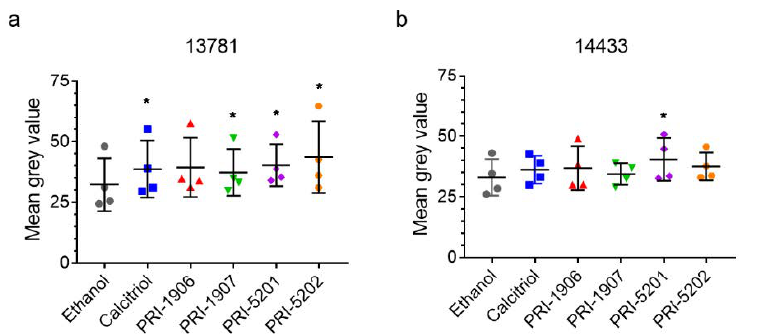
Figure 6. Nuclear VDR protein level in ( a ) 13781 and ( b ) 14433 cells after treatment with 100 nmol/L of an1,25Ds for 5 days. RM-ANOVA with Dunnett post-test vs. ethanol control, * p < 0.05, N = 4.